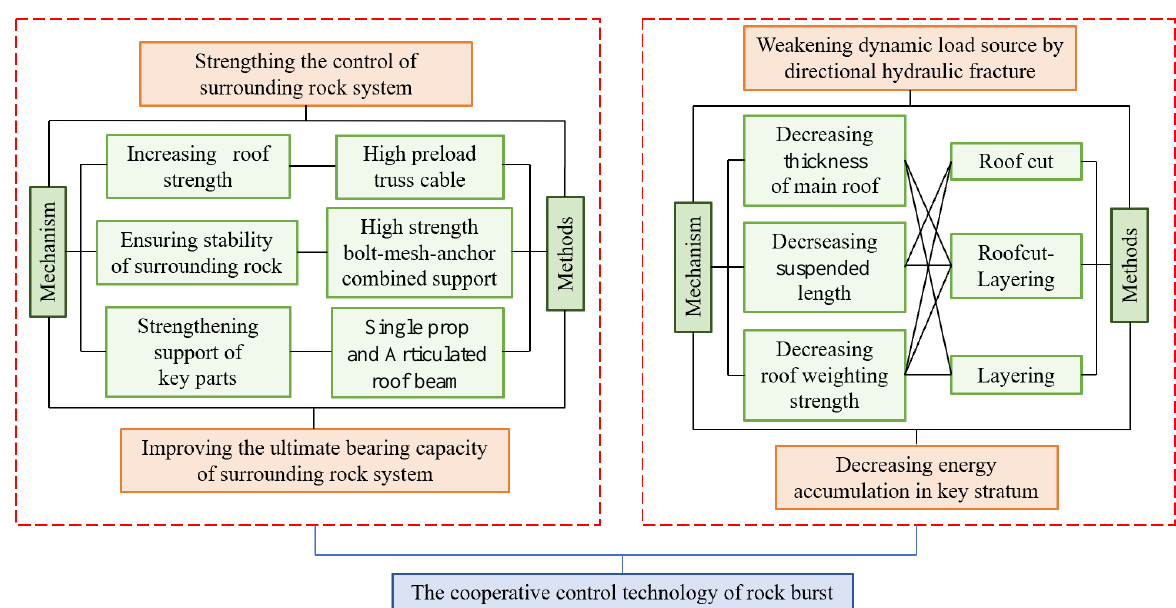
Figure 9. Cooperative control technology of rockburst in irregular working face (from [91]).